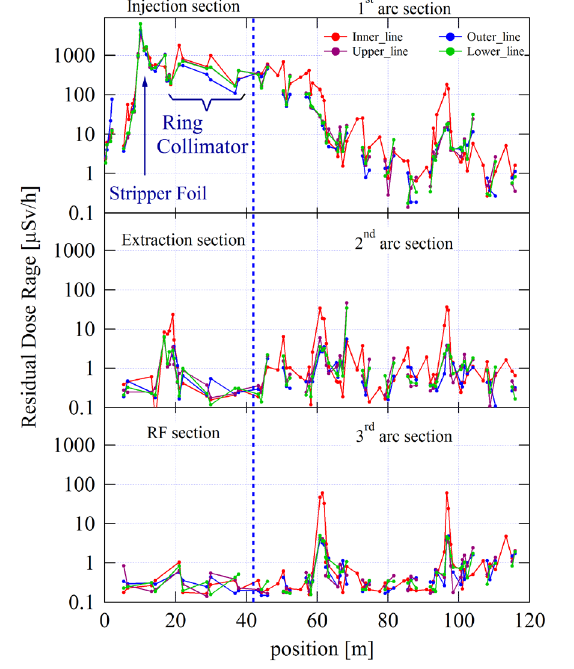
Fig. 2. Typical measurement results of residual dose rate distributions along the ring.